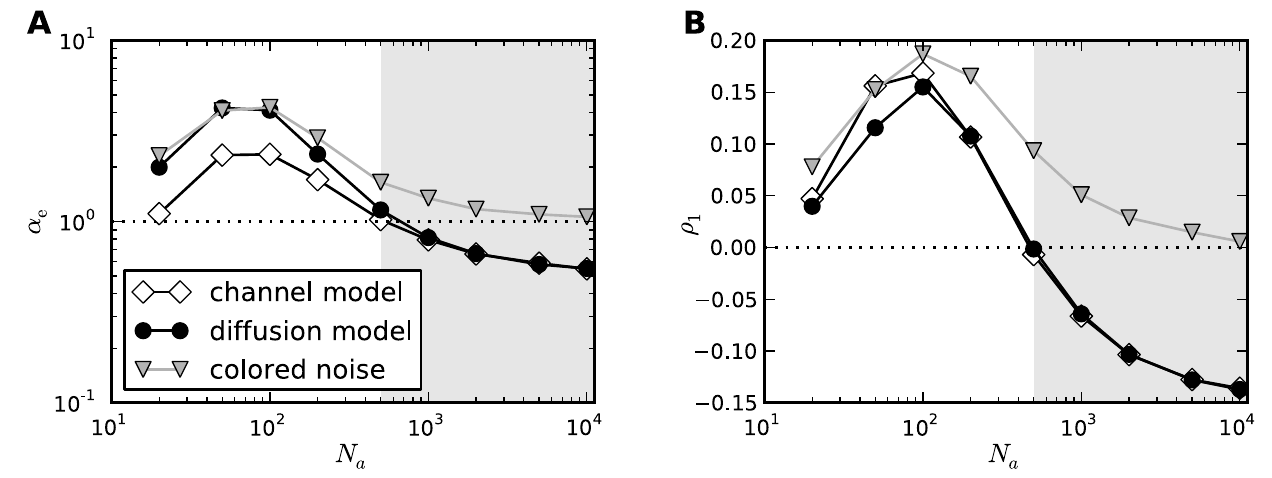
Figure 10. ISI statistics of the PIF model in the presence of both stochastic adaptation and white noise. For a fixed level of white noise (cid:3) ms ) the number of adaptation channels N ( D ~ 0 : 01 V 2 a was varied. For a small channel population slow channel noise dominates (white region), th whereas for a large population the fast fluctuations dominate (gray-shaded region). A Rescaled kurtosis a e for the channel model (white diamonds) and the diffusion model (black circles). The gray symbols display simulations where the adaptation was replaced by an effective colored noise as before but with the additional white noise input. The case of an inverse Gaussian is indicated by the dotted line. B Corresponding serial correlation coefficient at lag one. The zero line is indicated by the dotted line. The adaptation time constant was chosen as t w ~ 100ms , other parameters as in Fig. 2.